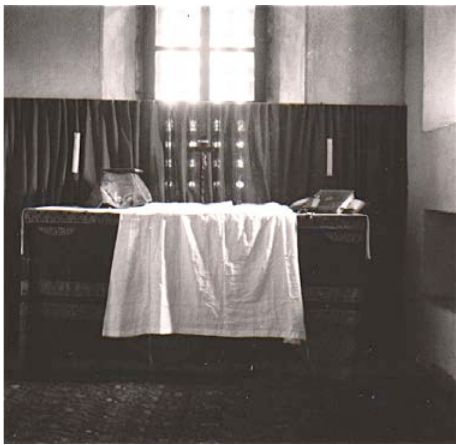
Fig. 2: The chapel inside Horsfield’s house. (Copyright UCL Institute of